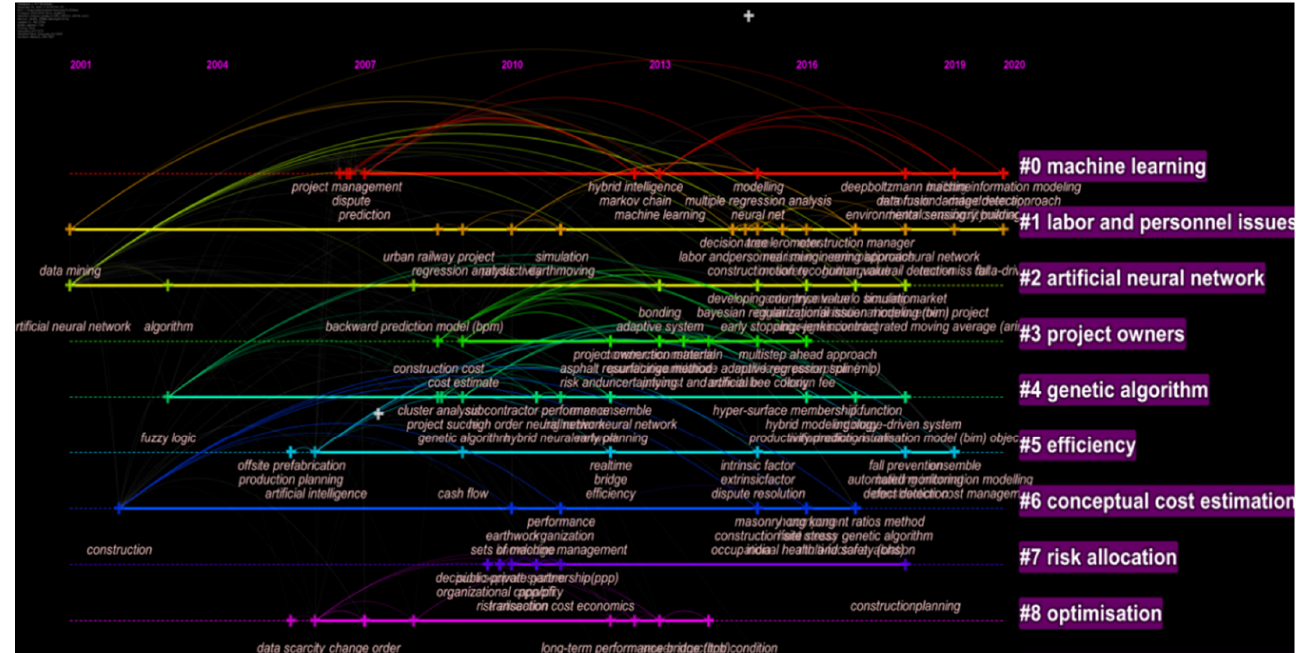
Figure 5. Timeline visualization of keywords (clustering structure).